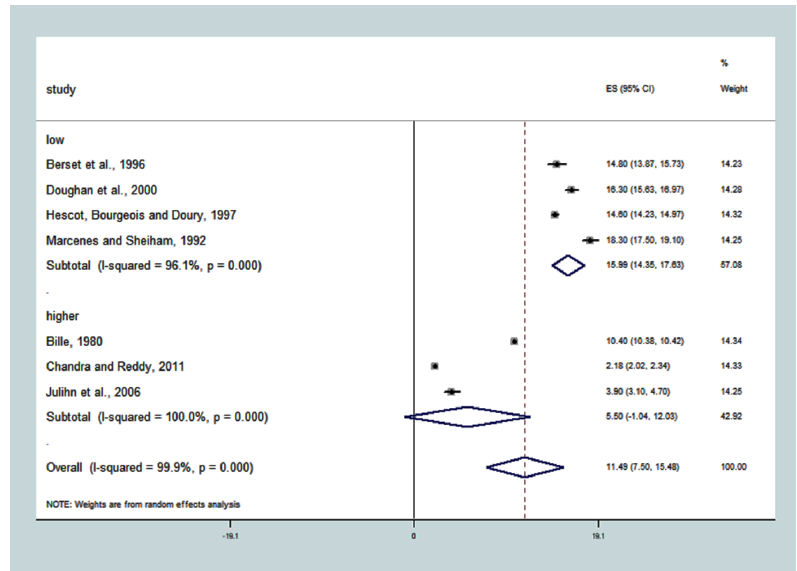
Figure 6. Association between ‘low socioeconomic status-SES’ and caries experience (DMFT). The pooled effect estimates from the random-effects meta-analysis are shown. Heterogeneity was assessed using the χ 2 test and I 2 statistics. The forest plots comparing caries in adults with ≥22.4% of the population had low socioeconomic status SES-low compared with <22.4% of the population with low SES-higher .